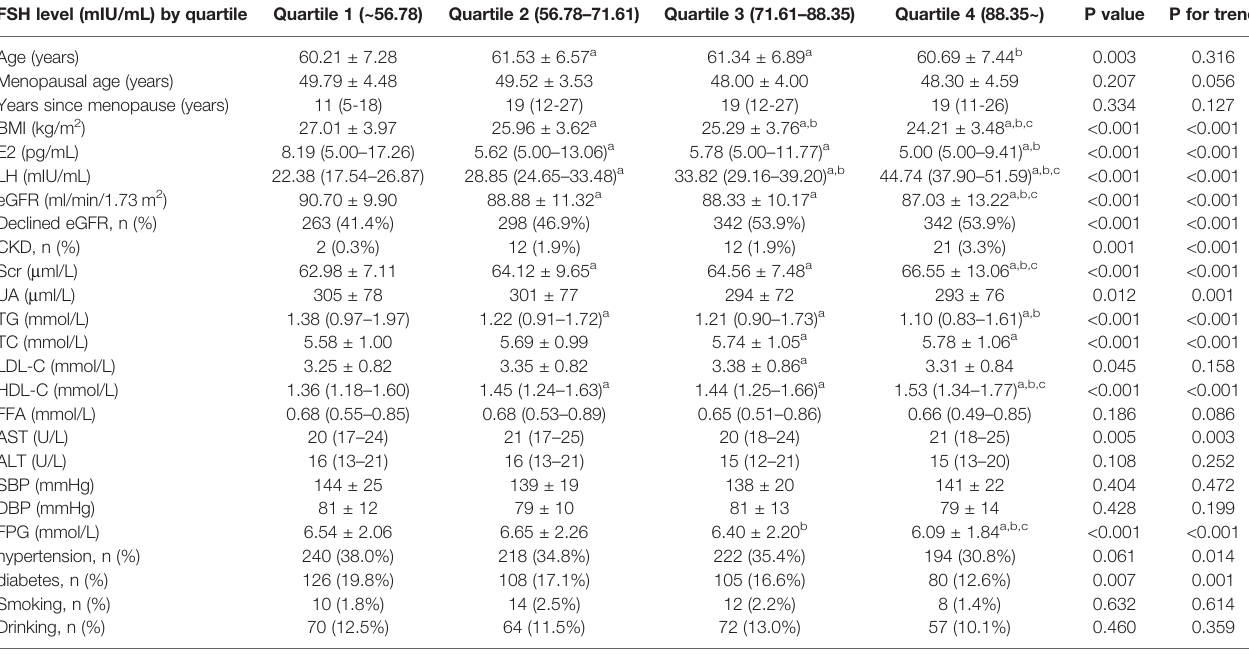
TABLE 2 | Comparisons among groups according to FSH quartiles in postmenopausal women. FSH level (mIU/mL) by quartile Quartile 1